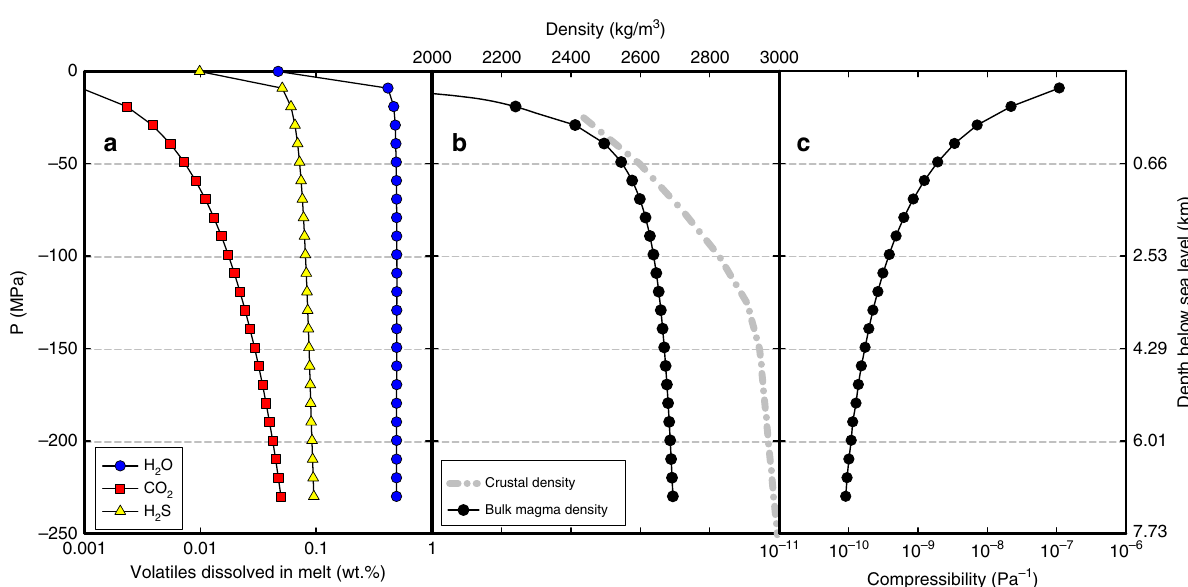
Fig. 6 Volatile content, magma and crustal properties versus pressure/depth. a Dissolved volatile contents (in wt.%) of the 2014 – 2015 Bárðarbunga magma versus pressure (in MPa, left vertical axis). b Bulk magma (black) and crustal (grey hatched) density (in kg/m 3 ) and c bulk magma compressibility (in Pa − 1 ). Conversion from pressure to depth below sea level is shown at the right vertical axis. See also Supplementary text and Supplementary Fig.